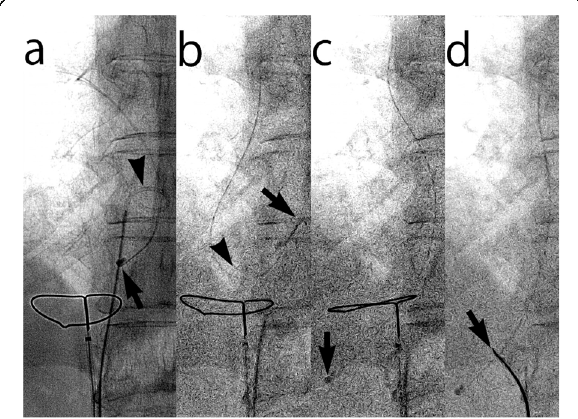
Fig. 2 Fluoroscopic images during the retrieval of a central venous catheter fragment with inaccessible ends in a 61-year-old female patient with colon cancer. The catheter was implanted 16 years ago to treat breast cancer and its fragment migrated to the right atrium for at least 3.5 years. a The lower end of the catheter fragment is located in the left hepatic vein (arrow). The pigtail catheter (arrowhead) is advanced through the snare loop and hooked to the catheter fragment. b The lower end of the catheter fragment is disengaged (arrow) by pulling the pigtail catheter (arrowhead). c The pigtail catheter is pulled further to drag the lower end of the catheter fragment inferiorly through the snare loop (arrow). d The snare loop tightens the catheter fragment immediately